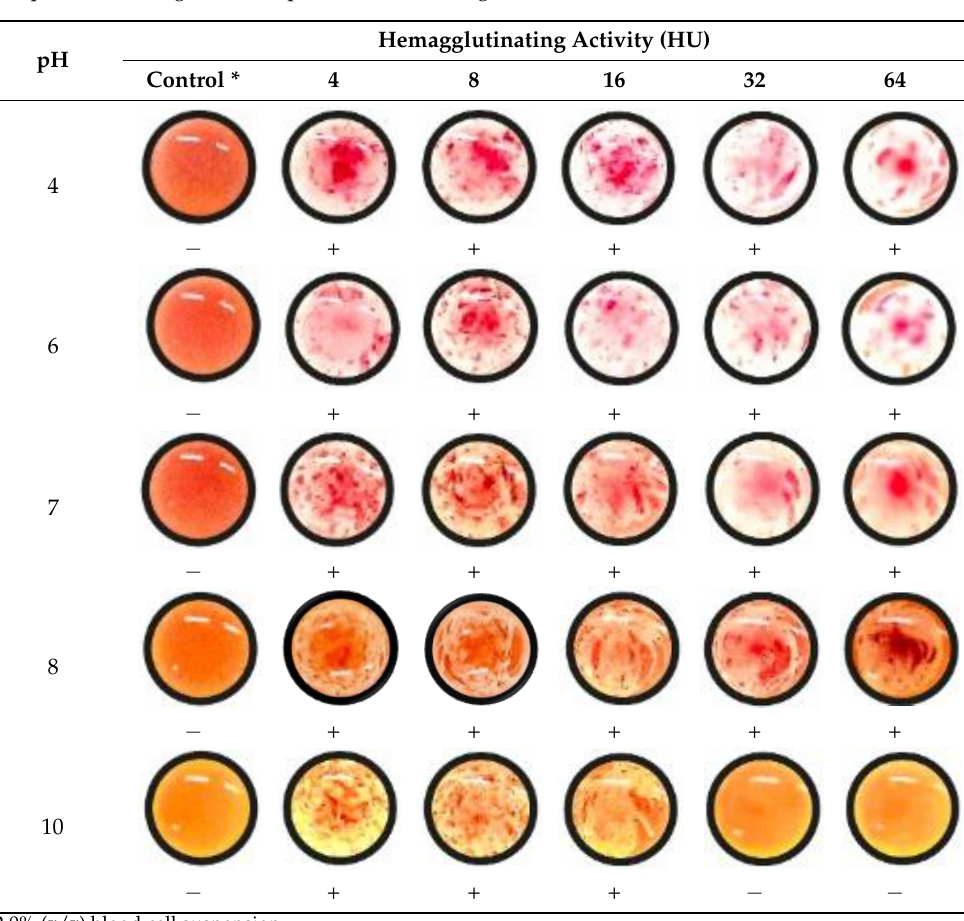
Table 1. Hemagglutinating activity induced by ABL – based extract after serial 2 – fold dilutions in PBS (4 ≤ pH ≤ 10). Images were captured after shaking the reaction wells.